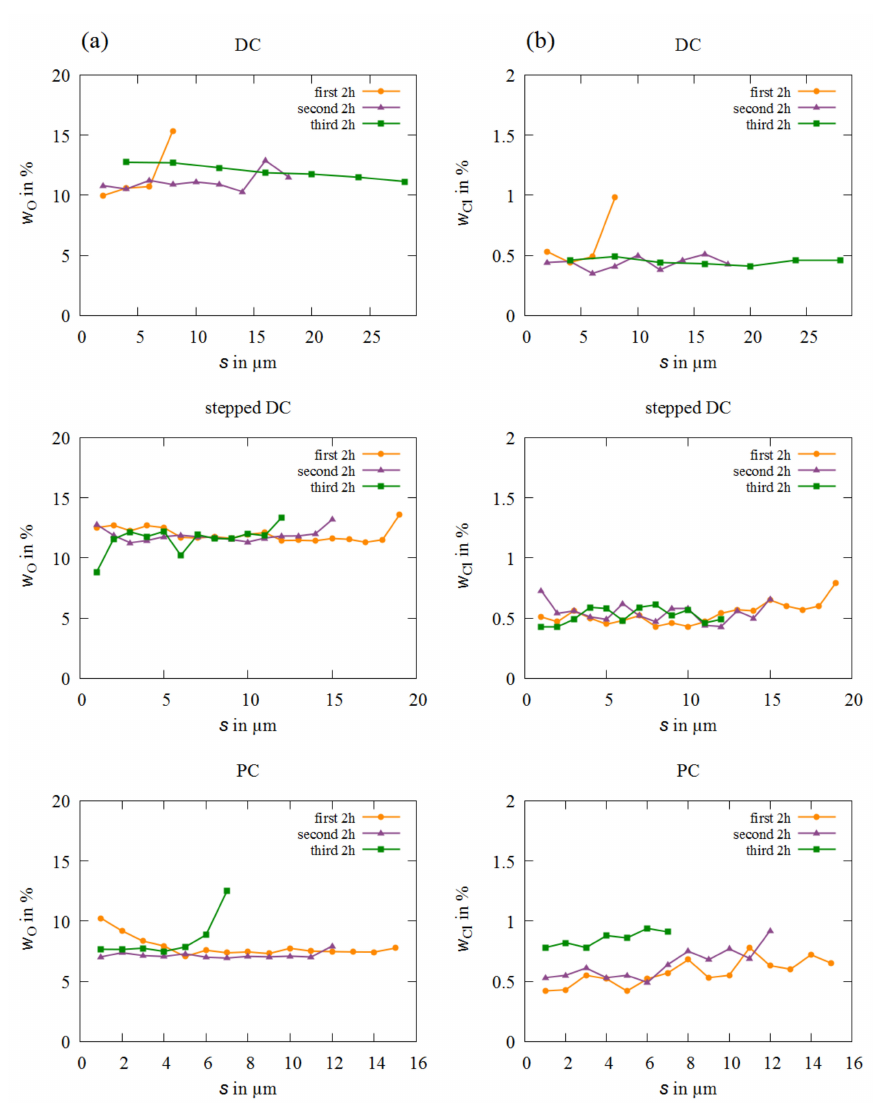
Figure 2. EDXS measurements of ( a ) the oxygen content and ( b ) the chloride content for each deposition mode depending on the distance from the substrate and the electrolyte